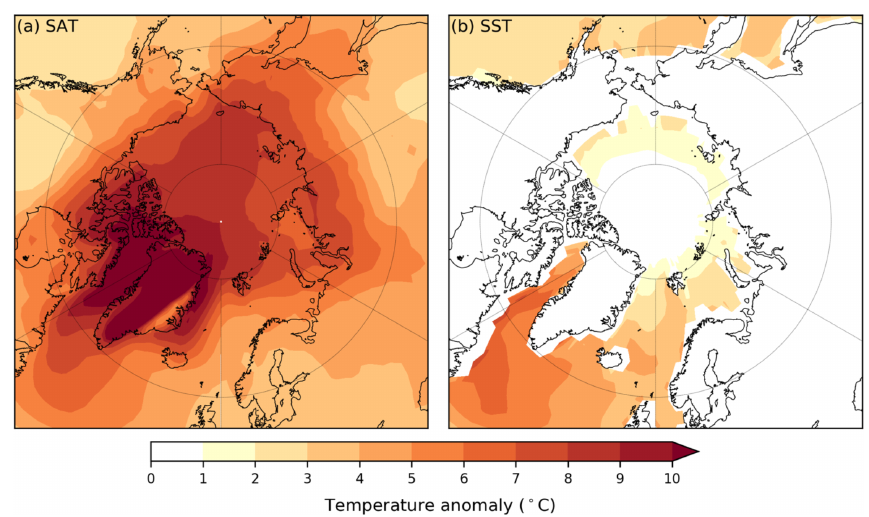
Figure 2. MMM annual temperature anomalies in the Arctic: (a) SAT and (b) SST. At least 15 out of 16 models agree on the sign of change at each